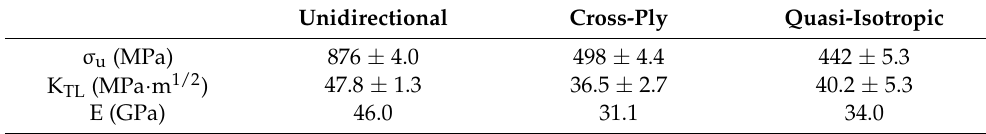
Table 1. Mechanical properties of the tested laminates (16 layers on each lay-up configuration).